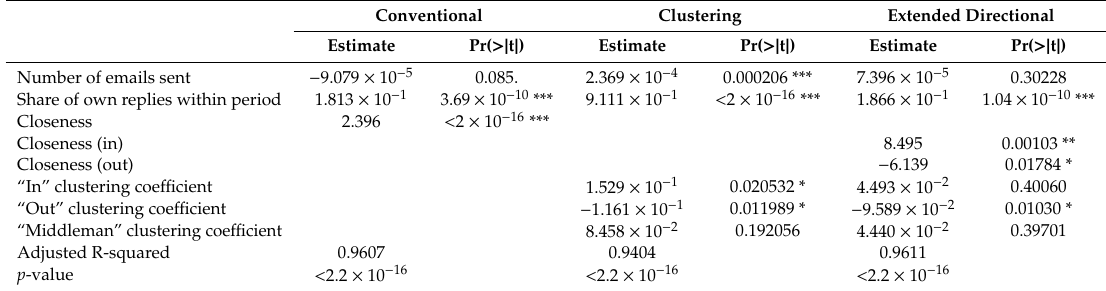
Table A2. College dataset, 1-day model.